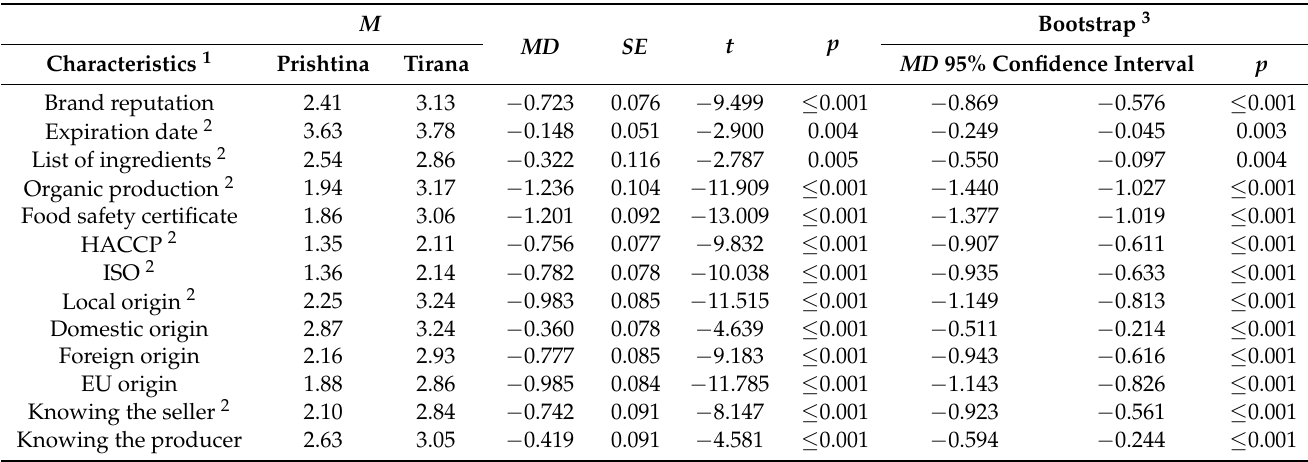
Table 4. Differences in the rating of food safety and quality cues between consumers from Kosovo (Prishtina) and consumers from Albania (Tirana) ( n = 649); unpaired two sample t -test including bootstrap